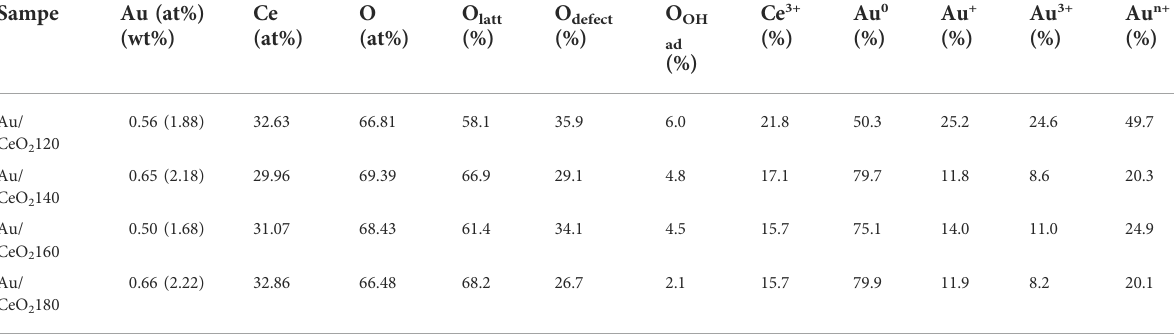
TABLE 3 Surface elemental composition and chemical states of the Au/CeO 2 X catalysts as inferred by X-ray photoelectron spectroscopy analysis. Sampe Au (at%)